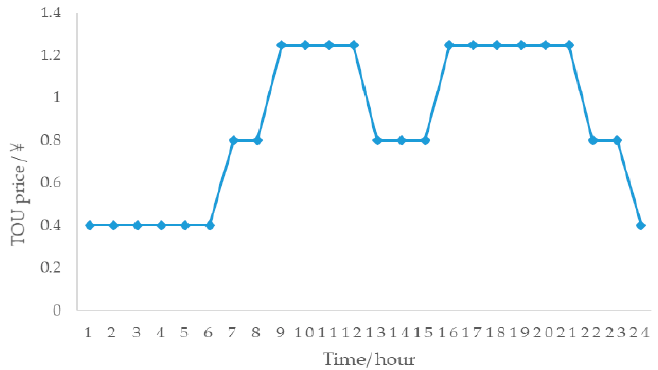
Figure A1. The TOU price. Figure A1. The TOU Table A1. Operating parameters.